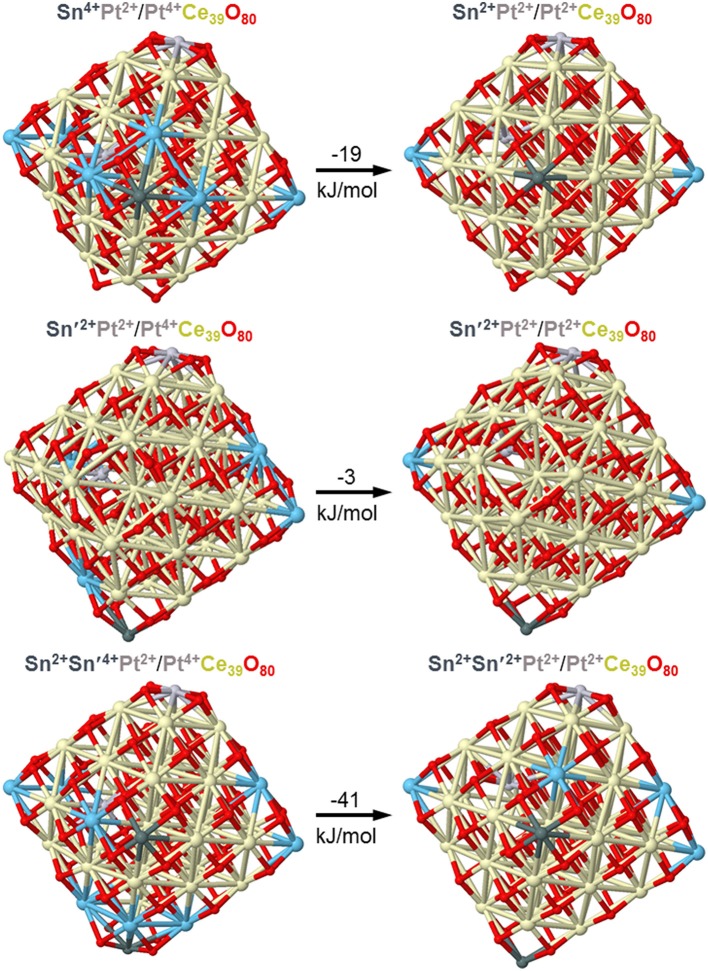
DFT optimized structures and relative energies of model Pt/PtCe39O80 nanoparticles interacting with one and two Sn atoms illustrating interplay of Pt4+ and Pt2+ oxidation states. Color coding for atoms: Ce4+-beige, Ce3+–light blue, O—red, Sn—dark gray, Pt—light gray. Atomic coordinates and total energies of the structures are given in the Supplementary Material.